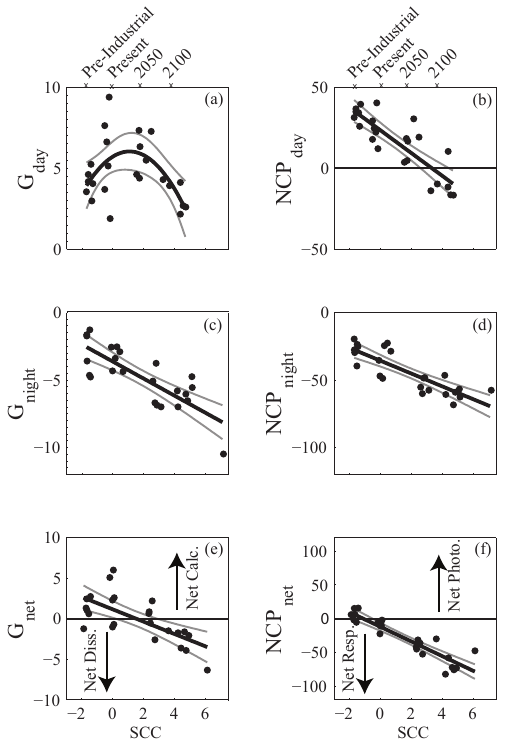
Figure 3. Net ecosystem calcification ( (a) G day , (c) G night , (e) and G net ) and net community production ( (b) NCP day , (d) NCP night , and (f) NCP net ) versus standardized climate change (SCC). Each point represents net ecosystem calcification (left panel) or net community production (right panel) calculated from an individual aquarium. Standardized climate change was centered around back- ground seawater conditions such that a value of 0 indicated that there was no change in p CO 2 or temperature. Positive values indi- cate an elevated p CO 2 and temperature condition relative to back- ground, and negative values represent lower p CO 2 and tempera- ture conditions. G day had a non-linear relationship with standard- ized climate change ( y = − 0.27 x 2 + 0.59 x + 5.7), while G night ( y = − 0.63 x − 3.6) and G net ( y = − 0.76 x + 1.1) each had a nega- tive linear relationship with standardized climate change (Table 2). NCP day ( y = − 7.01 x + 23.4), NCP night ( y = − 35.76 − 4.74), and NCP net ( y = − 12.07 x − 10.85) all had significant negative rela- tionships with standardized climate change. Black lines are best fit lines for each model with 95% confidence intervals in gray. The x ’s in the top panel represent the imposed conditions for pre-industrial, present day, 2050, and 2100. The black horizontal line in panels (b) , (e) and (f) shows the point where G and NCP equal 0. Points above the line are net calcifying (e) or net photosynthesizing (f) and points below the line are net dissolving (e) or net respiring (f) over the en- tire 24h period.